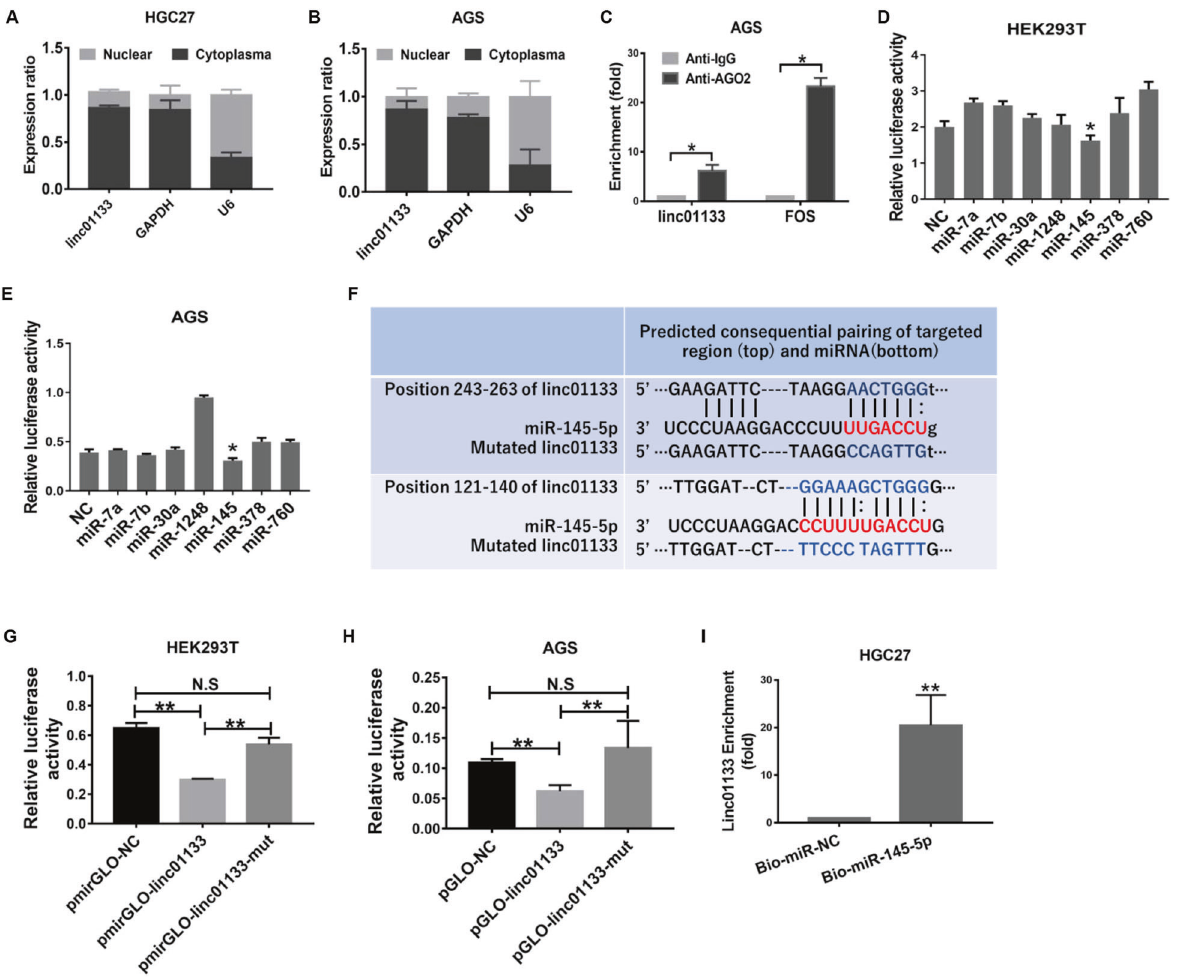
precipitated by anti-AGO2 antibody. D , E Out of the 7 candidate miRNAs, miR-145-5p reduced the luciferase activity of pmirGLO-linc01133 in HEK293T and AGS cells. F Predicted miR-145-5p binding sites and mutated sequence in linc01133. G , H MiR-145-5p reduced the luciferase activity of pmirGLO-linc01133 but not that with mutated miR-145-5p binding sites. I Biotin-labeled miR-145-5p pull-down assay showed enrichment of linc01133 by